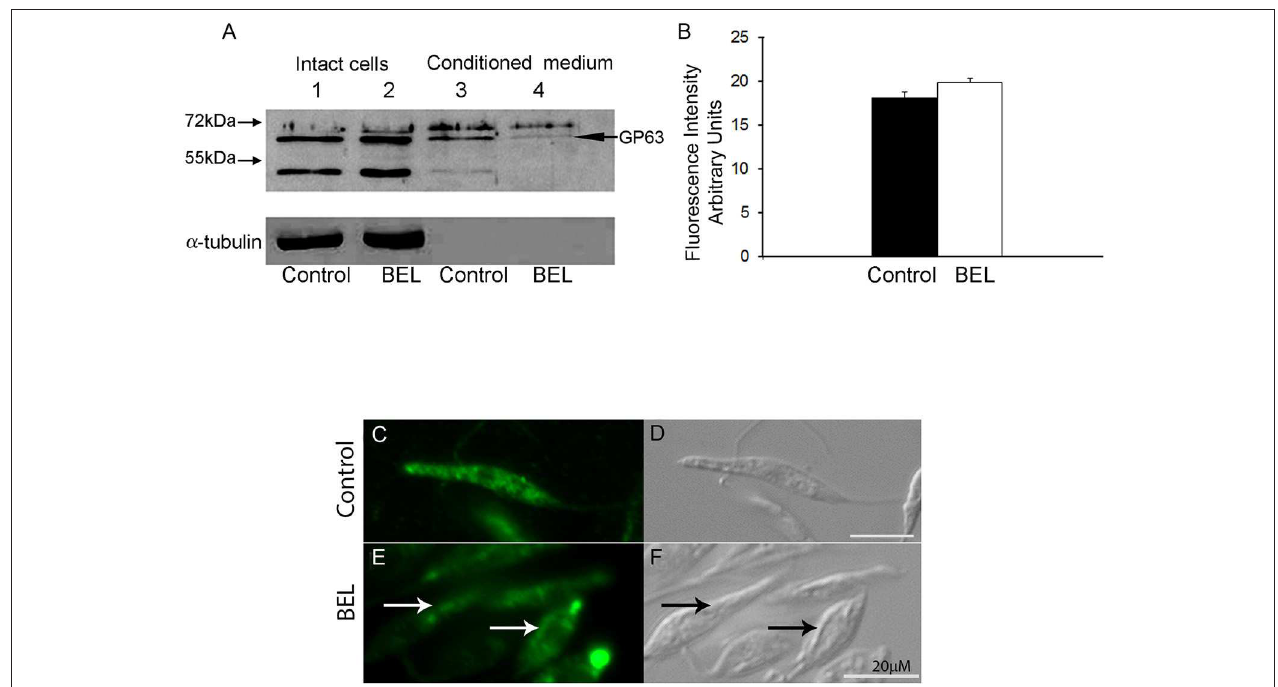
FIGURE 6 | Effect of bromoenol lactone (BEL) in the intracellular localization of GP63 in Leishmania amazonensis promastigotes. (A) Immunoblots of intact cell (lanes 1 and 2) and conditioned medium (lanes 3 and 4), probed with a polyclonal anti-GP63. Lanes 1 and 3, untreated controls; lanes 2 and 4, BEL-treated parasites. Molecular weight markers are indicated on the left, and the band corresponding to GP63 is indicated on the right. α -tubulin was used as loading control. (B) Flow cytometry analysis of GP63 intensity fluorescence in pre-fixed and permeabilized cells showing no statistically significant accumulation of the protein in BEL treated cells. (C–E) Fluorescence microscopy analysis of permeabilized cells labeled with anti-GP63 antibody. In control cells (C,D) , GP63 labeling was observed in small organelles distributed in the cell body (C) . In contrast, in BEL-treated cells (E,F) , labeling was less intense in the cytoplasm, and was concentrated in enlarged compartments in the anterior and posterior regions of the cell body, and in elongated structures that resembled the multivesicular tubule, running along the cell body (arrows in E and F ). Bars, 20 µ